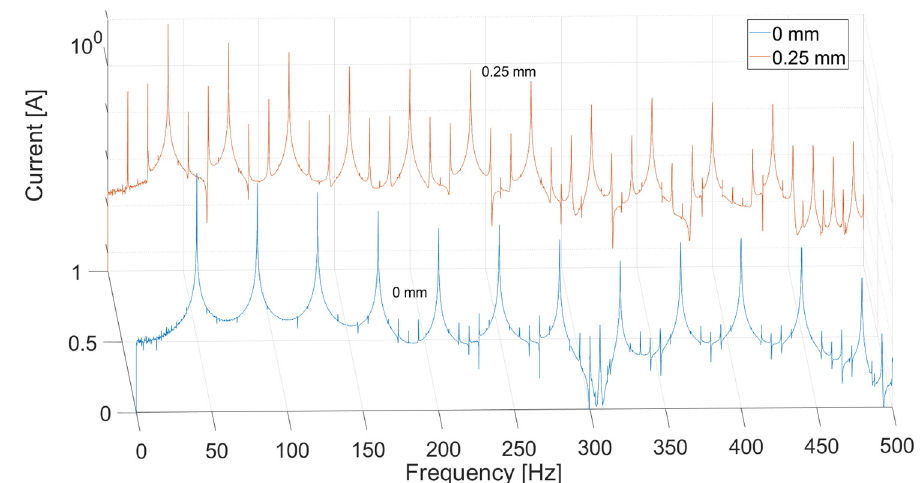
Figure 14. Phase current in frequency domain of constant voltage source in logarithmic scale.